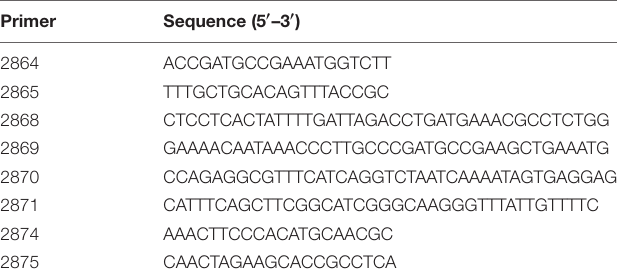
TABLE 1 | Nucleotide sequences of oligonucleotide primers used for PCR-based